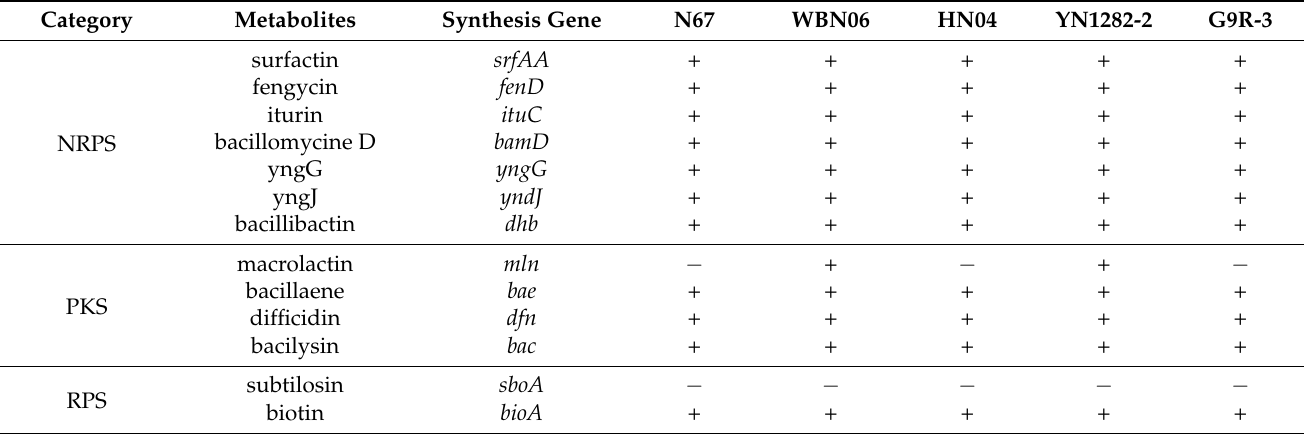
Table 3. The overview of biocontrol marker gene amplification status in tested strains of Bacillus. Category